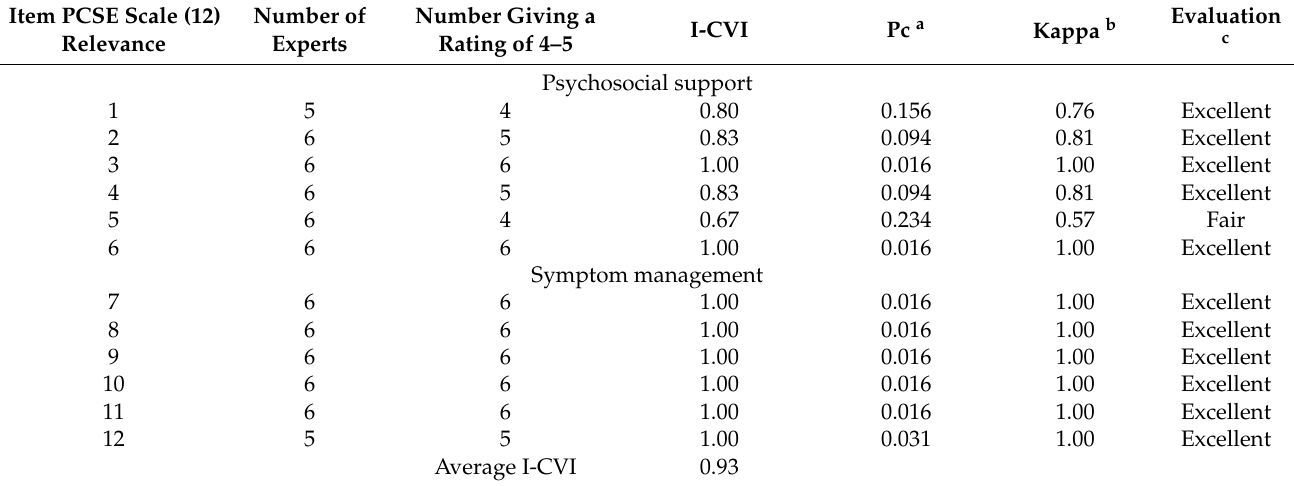
Table 4. Relevance of the PCSE scale: items, expert ratings, and